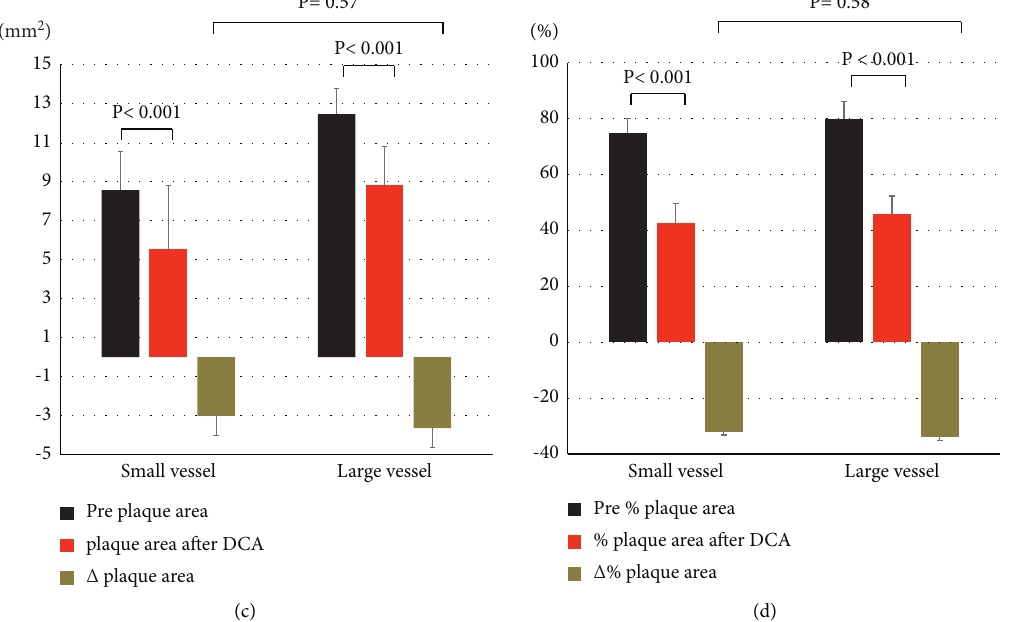
Figure 2: (a) Comparison of the lumen area before DCA, lumen area after DCA, and change in the lumen area between the small vessel and large vessel groups. (b) Comparison of the vessel area before DCA, vessel area after DCA, and change in the vessel area between the small vessel and large vessel groups. (c) Comparison of PA before DCA, PA after DCA, and change in PA between the small vessel and large vessel groups. (d) Comparison of %PA before DCA, %PA after DCA, and change in %PA between the small vessel and large vessel groups.